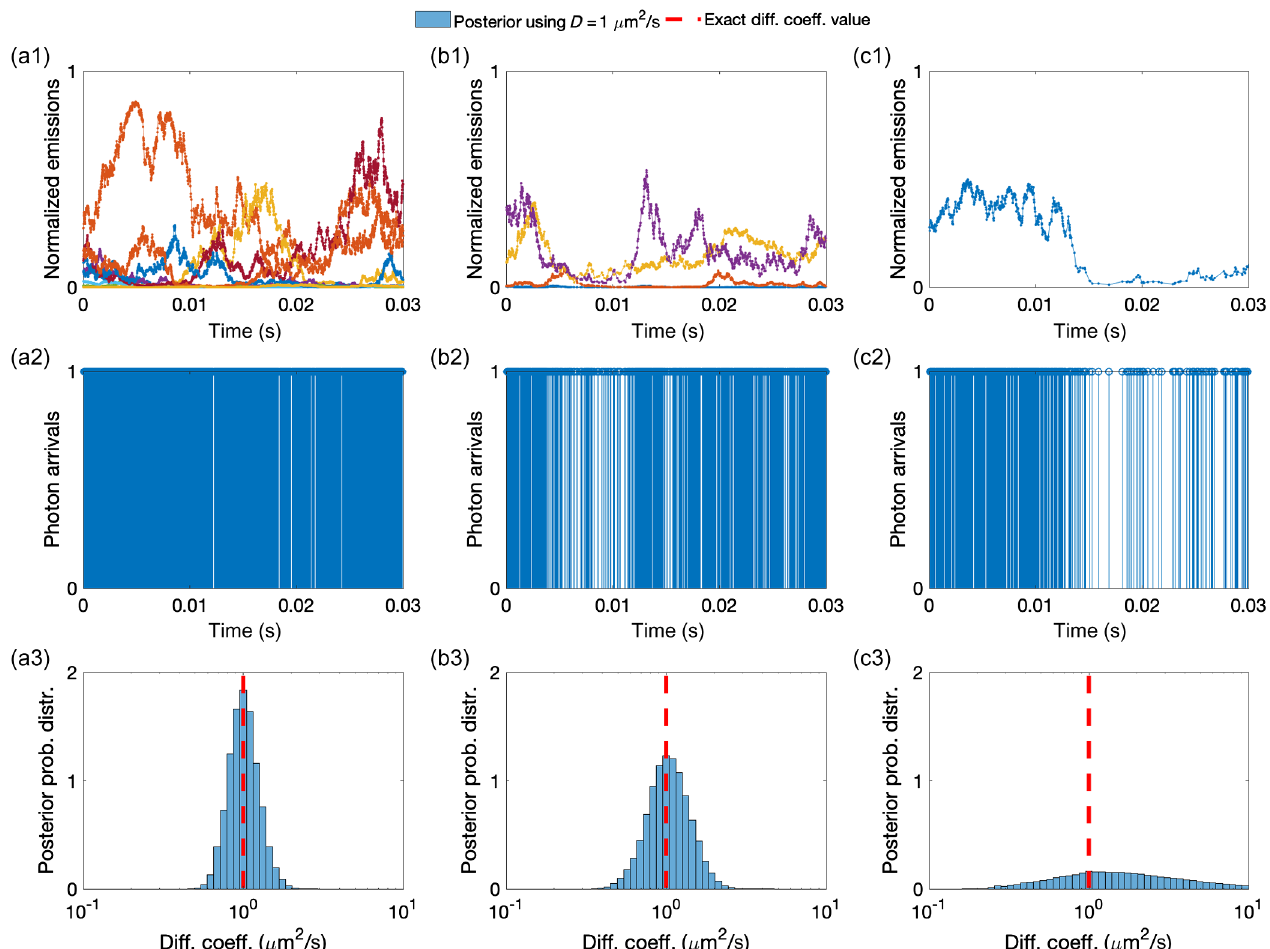
FIG. 5. A higher molecular concentration provides more photons per unit time and sharper diffusion-coefficient estimates. (a1),(b1), (c1) Instantaneous molecule photon emission rates μ n , normalized by μ . (a2),(b2),(c2) Photon arrival traces resulting from combining mol k photon emissions from every molecule and the background. These are produced by ten molecules containing ≈ 3000 photon arrivals (a2), four molecules containing ≈ 2000 photon arrivals (b2), and one molecule containing ≈ 1000 photon arrivals (c2), diffusing at 1 μ m 2 = s for a total time of 30 ms under background and molecule photon emission rates of 10 3 photons = s and 4 × 10 4 photons = s, respectively. (a3),(b3),(c3) Posterior probability distributions drawn from traces with differing number of molecules [shown in (a2),(b2), (c2)]. As expected, for the traces with higher number of molecules, the peak of the posterior matches with the exact value of D (dashed line). Gradually, as we decrease the total number of molecules the estimation becomes less